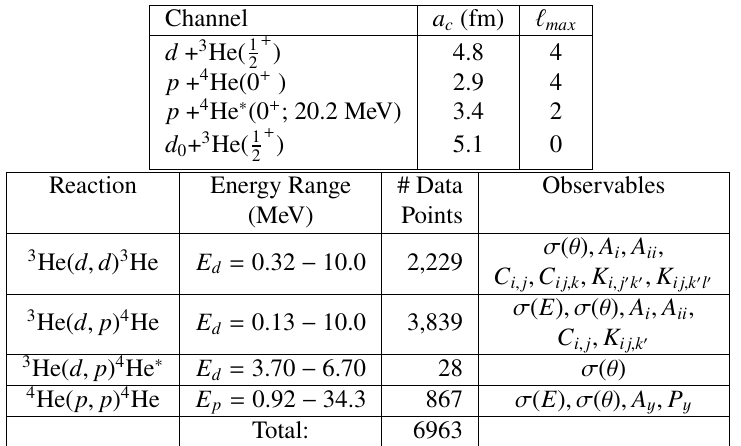
Table 1. Channel configuration (top) and data summary (bottom) for the 5 Li system analysis. The column labeled “Observables” indicates the following data types: σ ( E ) , integrated cross section; σ ( θ ) , unpolarized angular distributions (energy-dependence suppressed); A initial-state analyzing power; P final-state polarization; C spin correlation coefficients; K polarization transfer coefficients. (We have suppressed the indices i , j ,... which take on values x ,y, z for spins/polarization directions in configuration space.) All polarization and spin distributions are angular distributions, which depend on the angle of the outgoing particle. Chi-squared per degree of freedom for the analysis is χ 2 / dof (cid:39) 2 . 7 over 7,178 data points, 215 of which were discarded by eliminating individual data points which contribute to χ 2 > 40 .